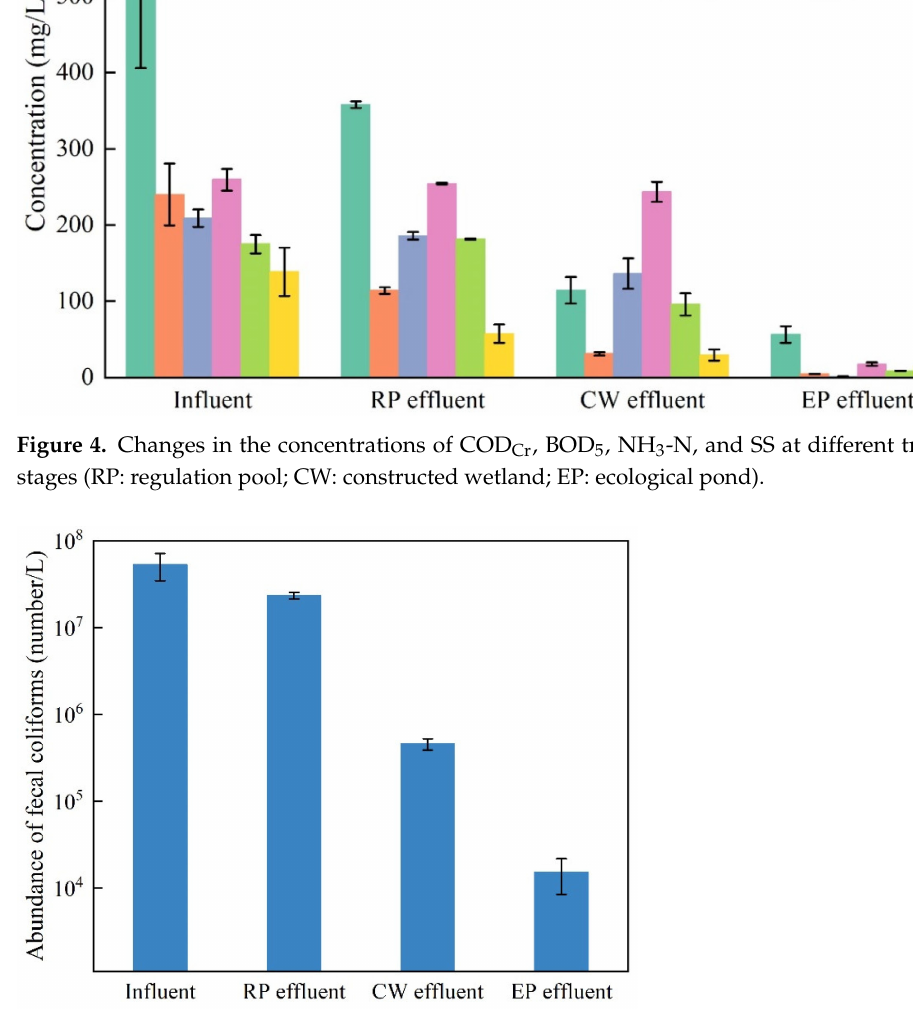
Figure 5. Changes in the abundance of fecal coliform at different treatment stages (RP: regulation pool; CW: constructed wetland; EP: ecological